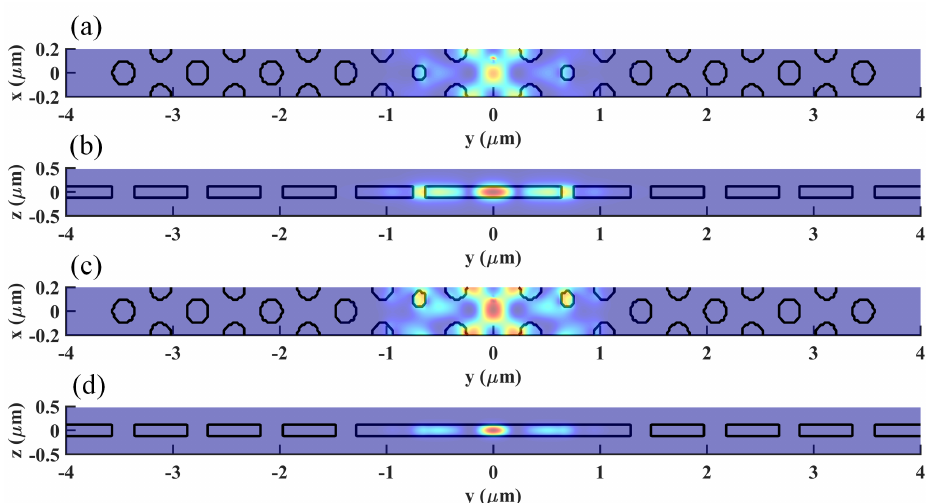
Figure 9. The electric field profiles for different structure parameters and observation planes, i.e., z = 0 plane for ( a , c ), x = 0 plane for ( b , d ). While R2 = 0.16 a , ∆ x = 0 nm in ( a , b ), R2 = 0.16 a , ∆ x = 100 nm in ( c , d ). The definition of the axes has been given in Figure